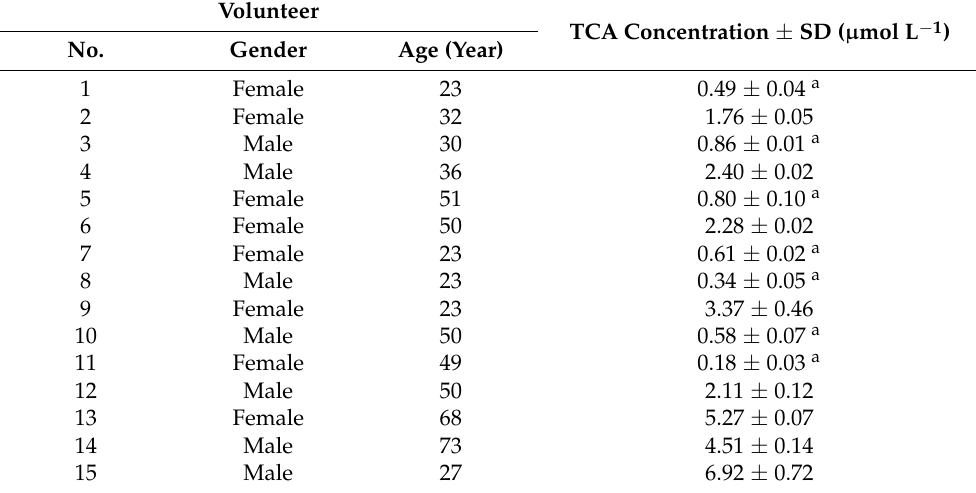
Table 4. Concentration of 1,3-thiazinane-4-carboxylic acid (TCA) in human urine ( n = 15).